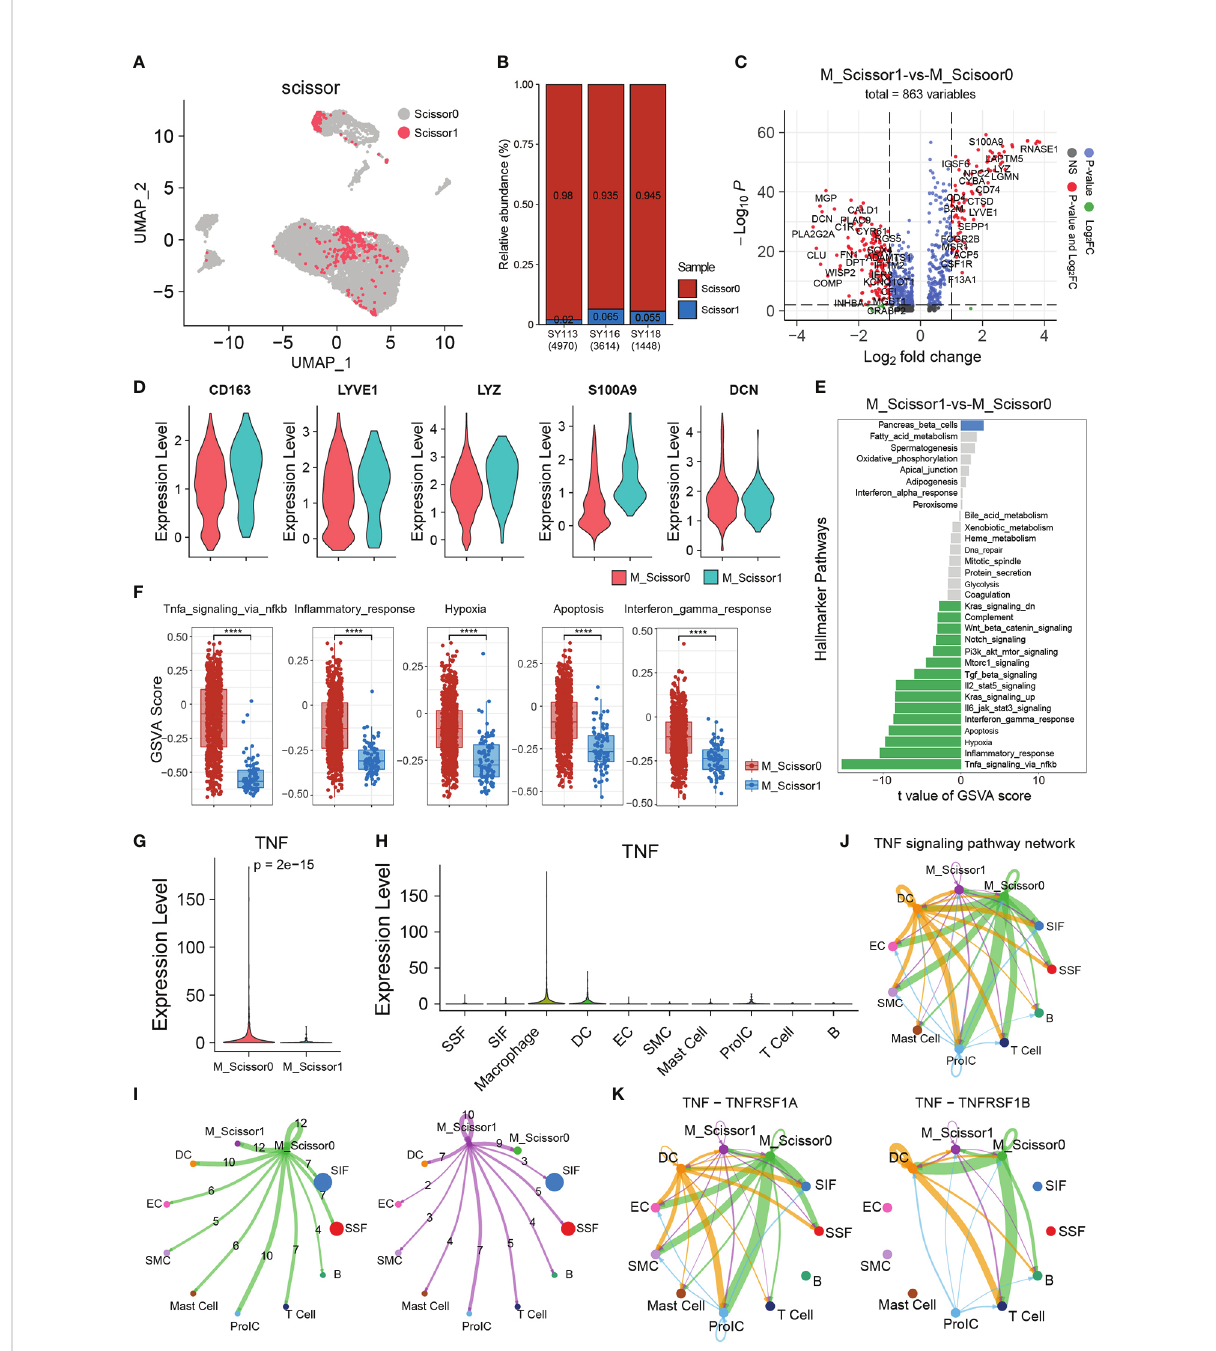
FIGURE 6 Scissor identi fi cation results on Macrophage. (A) The UMAP visualization of scRNA-seq datasets, scisoor1 represents that cell identi fi ed to be positively associated with transcriptome synovial in fl ammation, scissor0 were the background cells. (B) The bar plot shows the proportion of scissor cells in the three scRNA-seq samples. (C) The volcano plot of differential gene expression in scissor1 Macrophages (M_Scissor1) versus scissor0 Macrophages (M_Scissor0). (D) The violin plots show the several signi fi cant upregulated genes (RNASE1, CQB, S100A9, LYZ, and CD163) in M_Scissor1 group. (E) GSVA enrichment analysis of the hallmarker signaling pathways in Macrophage scissor group. (F) The Box plot shows the signi fi cant signaling pathways in gsva analysis. (G) The TNF gene expression in Macrophage scissor group and speci fi c express in M_Scissor1 group. (H) The violin plot showing TNF gene expression in each cell type. (I) The cell communication number in Macrophage scissor group cells. (J) TNF signaling pathway usage in each cell clusters. (K) The ligand-receptor pairs usage of TNF signaling pathway in each cell